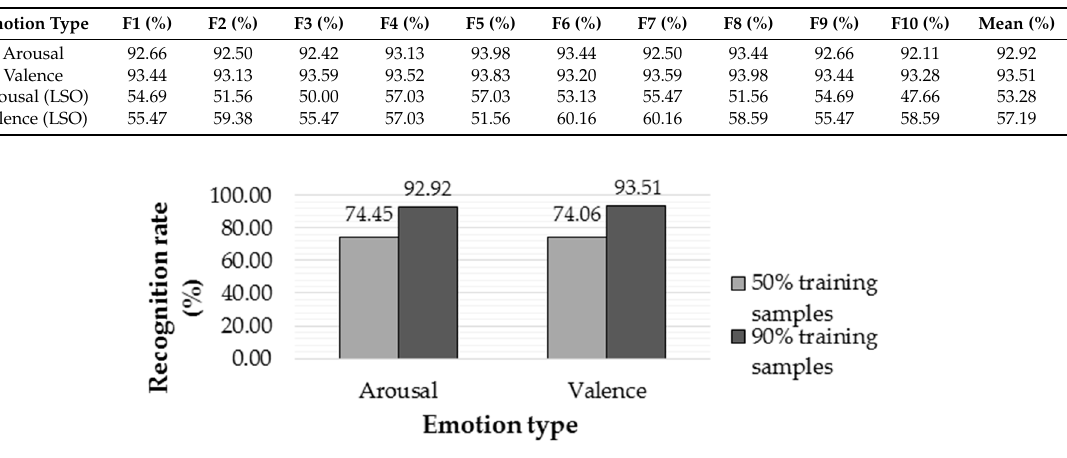
Table 5. Result of the 10-fold cross-validation recognition rate for mean percentage feature type from 8 EEG channels with 5 × 5 non-overlapped filters.